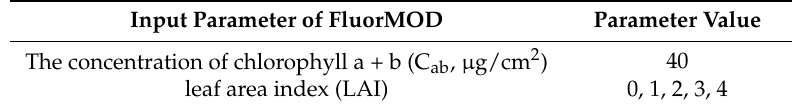
Table 2. Parameters of the vegetation spectrum with different leaf area indices simulated by